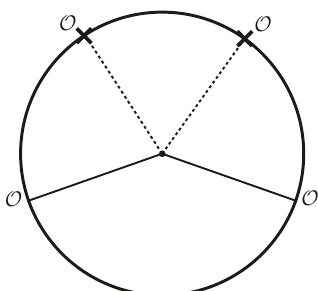
Figure 9 . Witten diagram for the leading e(cid:11)ective Hamiltonian contribution due to a bulk quartic interaction. The bulk-to-boundary propagators of the two zero modes (dashed lines) have delta- function singularities in x + , leading to a nonvanishing Hamiltonian matrix element for the physical external states (solid